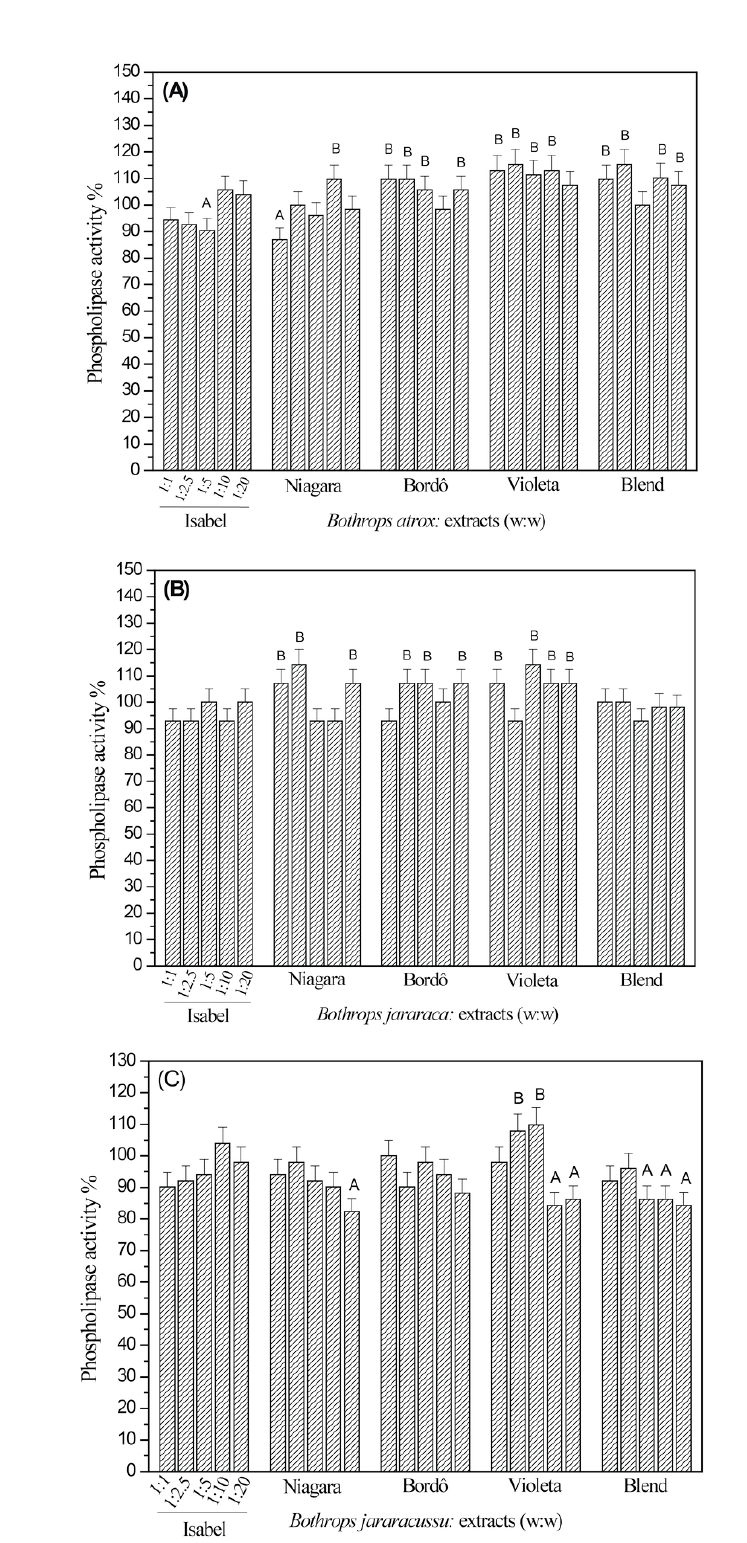
FIGURE 3 - Effect of dried grape pomace from different cultivars on venom induced phospholipase activity of Bothrops atrox (A), B. jararaca (B) and B. jararacussu venoms (C). The data represent means and standard deviation of values obtained in three independent tests performed with samples evaluated in triplicate. Controls (+) containing only venom (30 μg) were considered as 100% activity. A = differs from the positive control in inhibition. B = differs from the positive control in